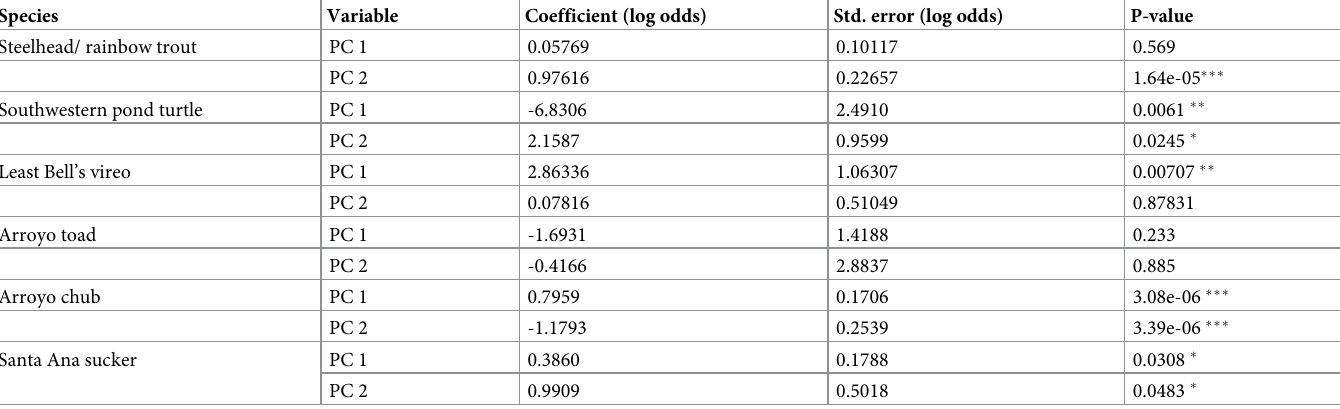
Table 3. Logistic regression results from the species distribution model driven by stream temperature.